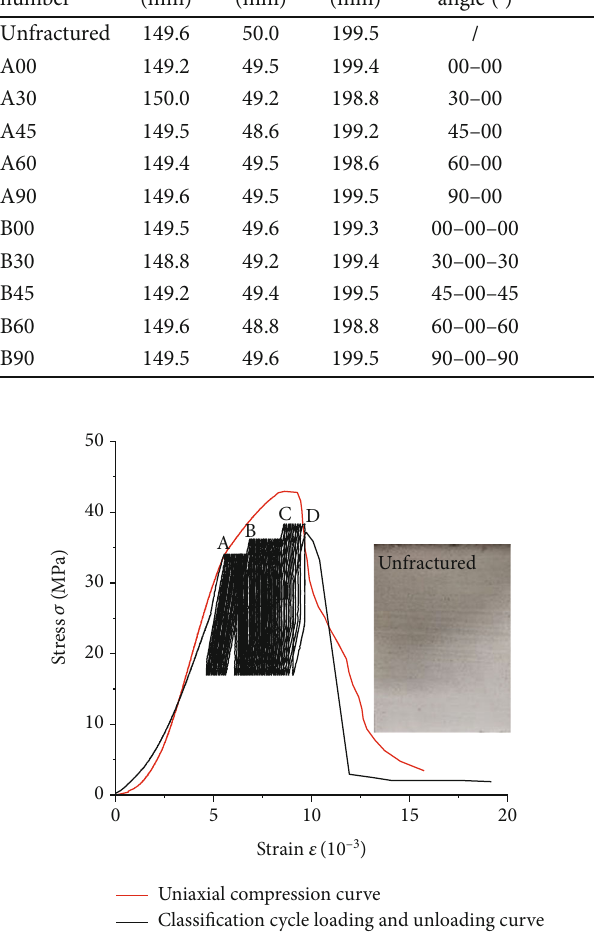
Figure 4: Stress – strain curves for the unfractured sample under two loading